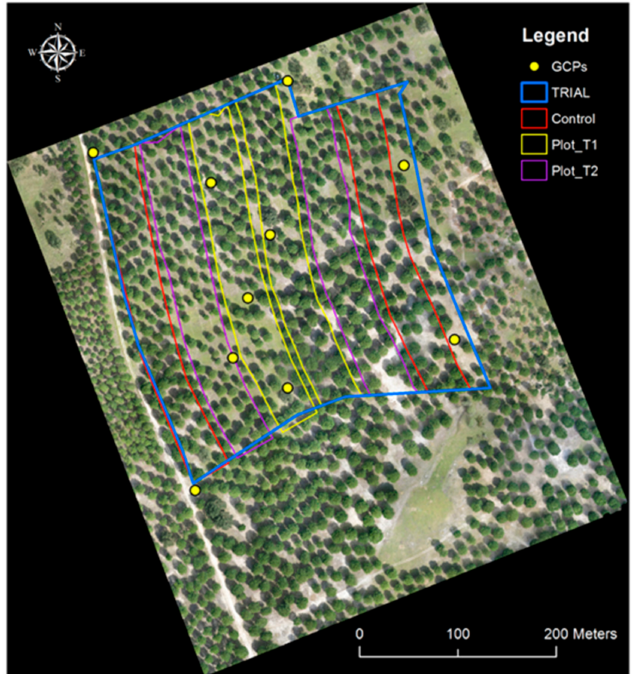
Figure 1. UAV-RGB-Orthomosaic image of the study area. Study site (blue line) showing the locations of the different plots and treatments (red, yellow and magenta polygons) and ten ground control points (GCPs) (yellow